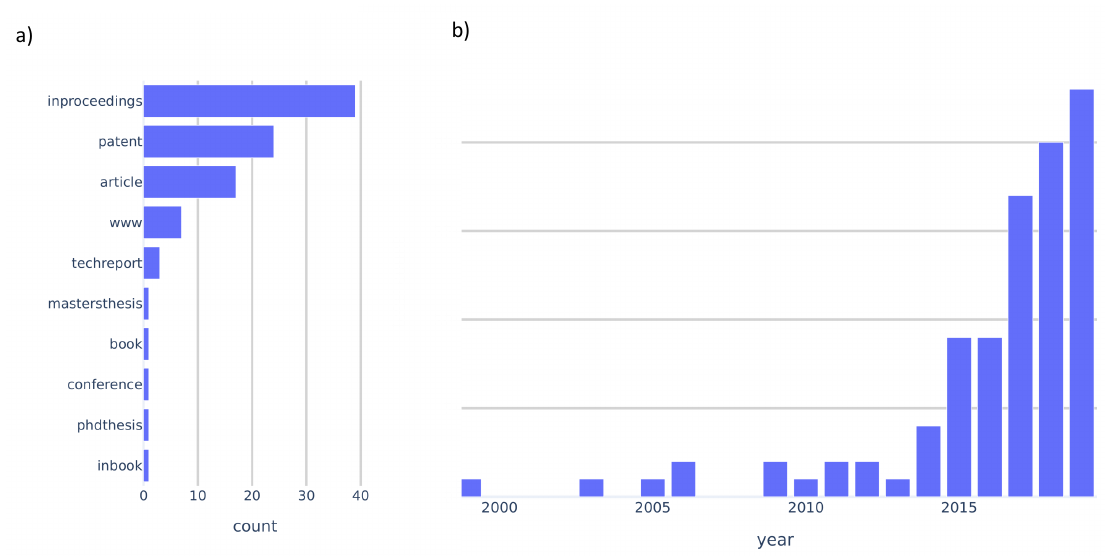
Figure 5. Overview of BibTeX publications which were analysed (N = 95). ( a ) shows the counts of BibTeX classes. ( b ) shows the number of publications per year.